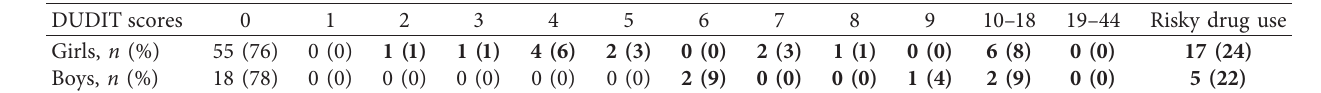
Table 2: DUDIT scores from the screening.